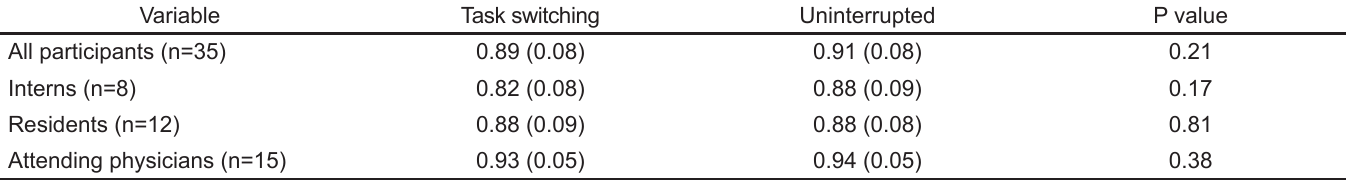
Table 1. Mean accuracy (standard deviation) in interrupted and uninterrupted simulations, overall and stratified by position. Hypothesis testing performed using paired t-tests.